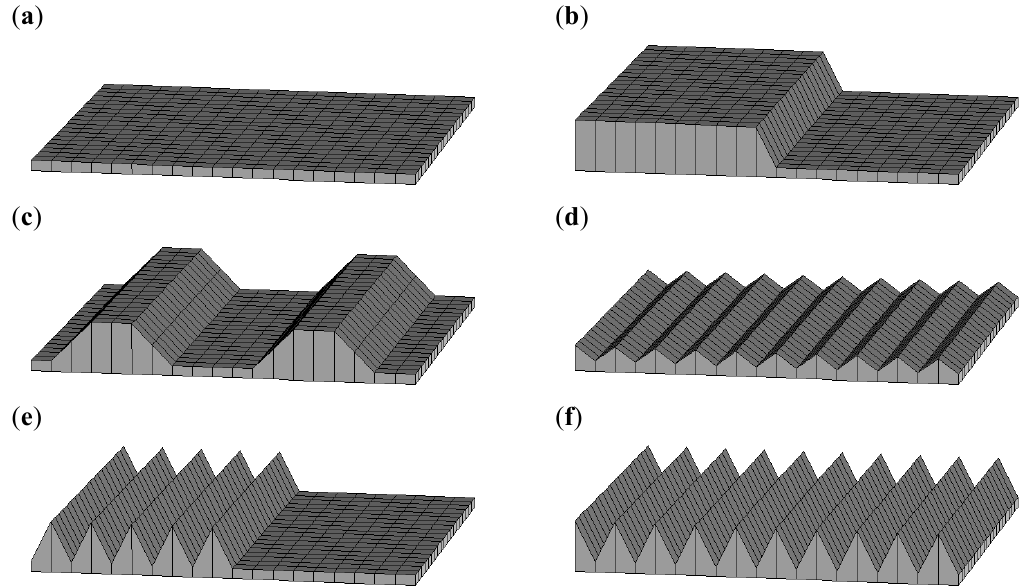
Figure 2. Artificial test surfaces, which were used to select sensitive indices of small-scale micro-relief heterogeneity: ( a ) perfectly smooth surface; ( b ) perfectly smooth surface with one step of 0.8 m; ( c ) mixture of perfectly smooth surface and two big humps (range 0.8 m); ( d ) rough surface (range: 0.3 m); ( e ) even mixture of perfectly smooth and very rough surface (range 0.8 m); ( f ) very rough surface (range: 0.8 m).